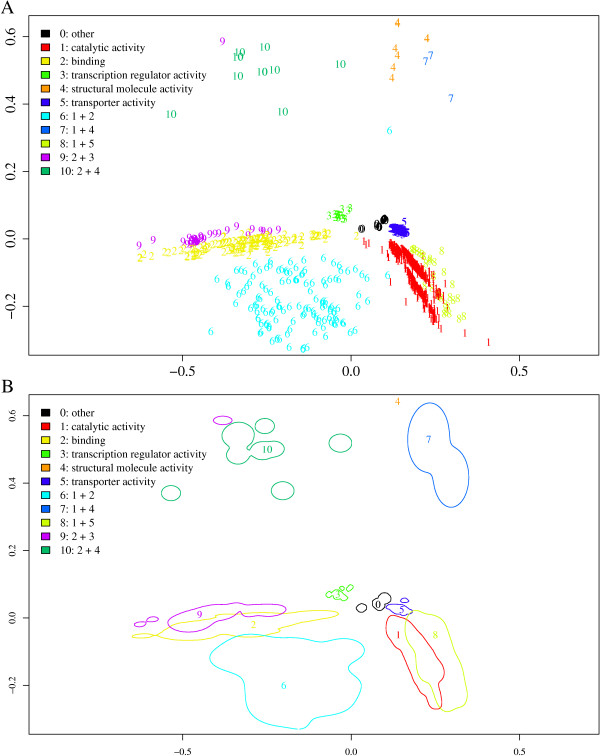
Yeast functional map. A: The yeast functional map, obtained by 2D-Multidimensional scaling of an all-against-all comparison of yeast proteins using dmf. The proteins are represented by numbers in the plot and are colored according to their type of molecular function. The plot shows that the proteins group into clusters according to their different functions. Additionally, proteins annotated with two terms are placed between the clusters that correspond to the single functions. B: Contour plot of the MDS.